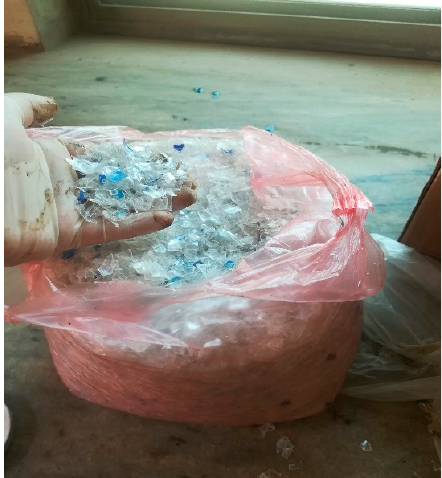
Figure 5. Crushed PET pellets.